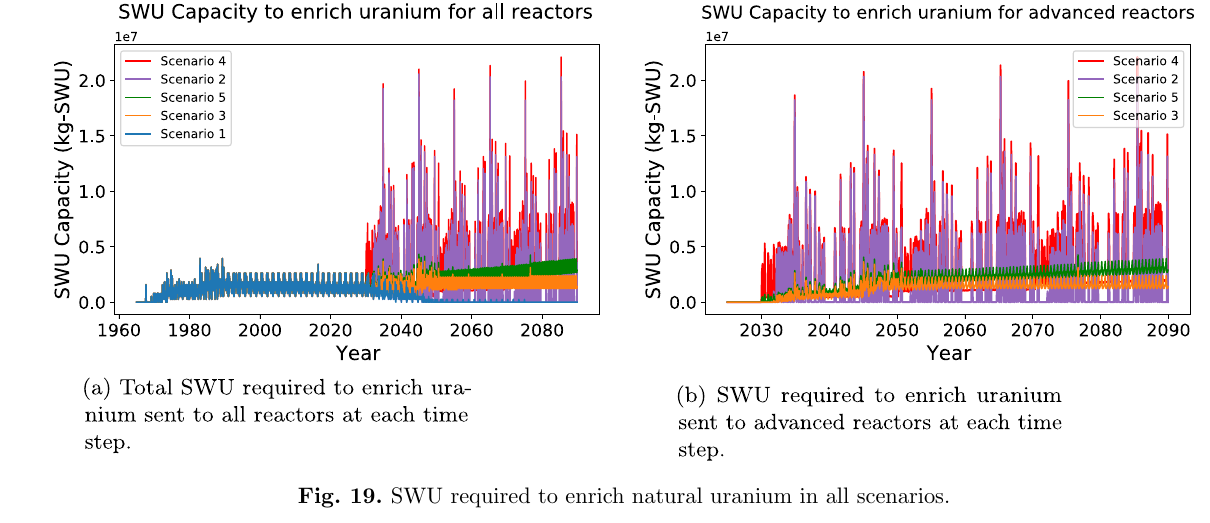
Fig. 19. SWU required to enrich natural uranium in all scenarios.